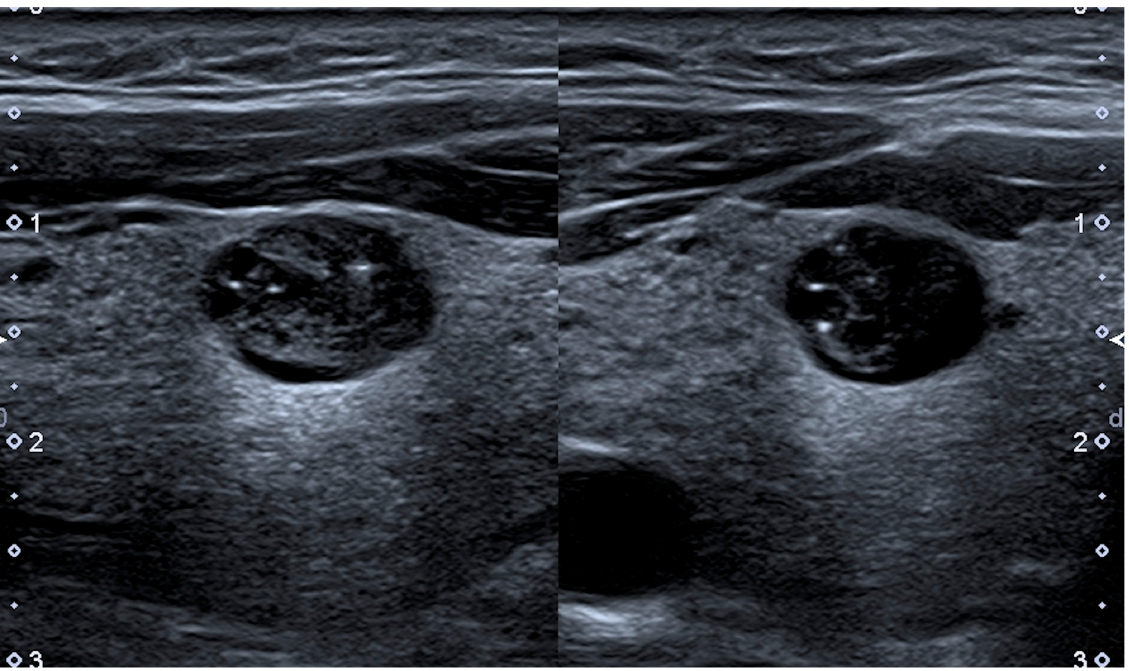
Figure 1. Longitudinal ( left picture) and transverse ( right picture) of an oval shaped, isoechoic nodule of mixed composition with hyperechoic spots located at the bottom of microcystic cavities. The nodule measures 11 × 9 × 7 mm. Classification: Chilean-TIRADS 2, Kwak-TIRADS 4a, BTA U3, AACE Class 2, ATA not classifiable as being of mixed composition with hyperechoic spots, K-TIRADS 4, EU-TIRADS 3, ACR-TIRADS 4, C-TIRADS 4A. Note: magnification × 3; scale bar: 1 cm/unit; TIRADS = Thyroid Imaging and Reporting Data System.